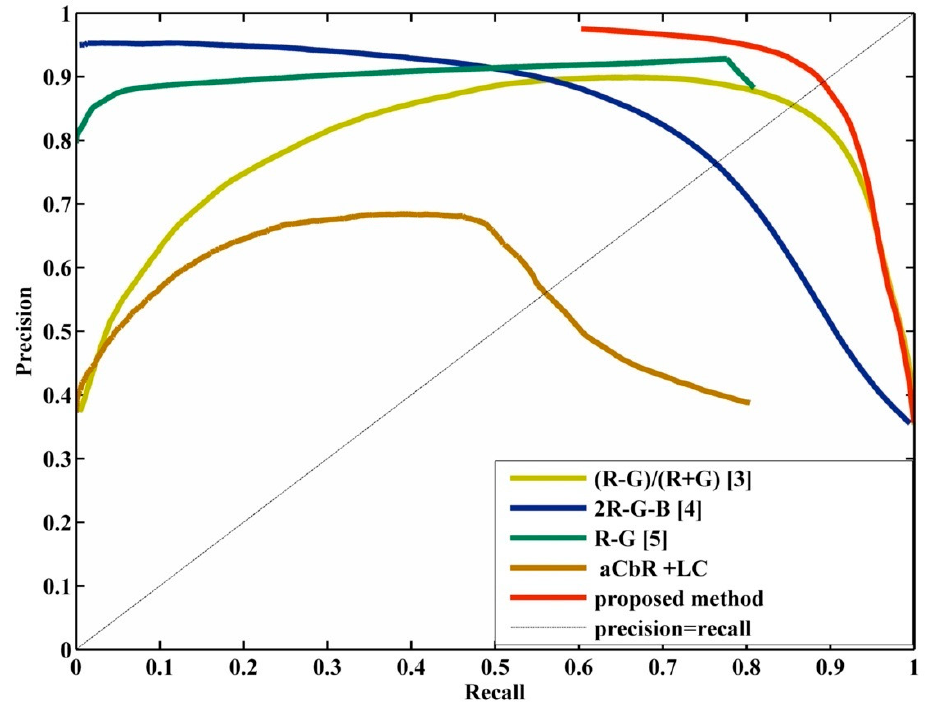
Figure 7. P-R curve of different methods.